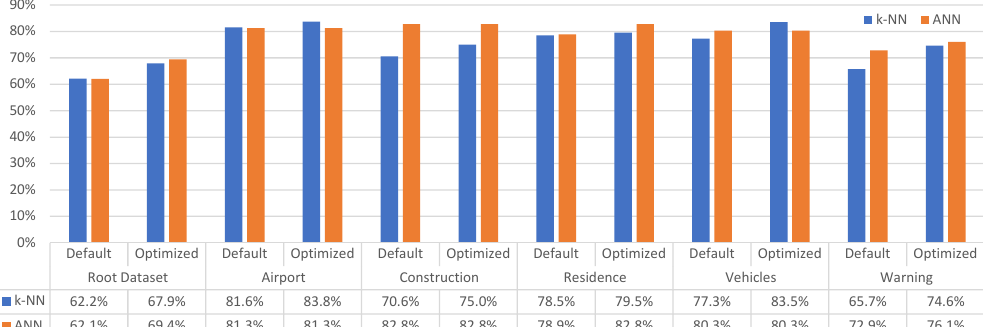
Figure 11. Achieved accuracy of the classifiers with their default and optimized